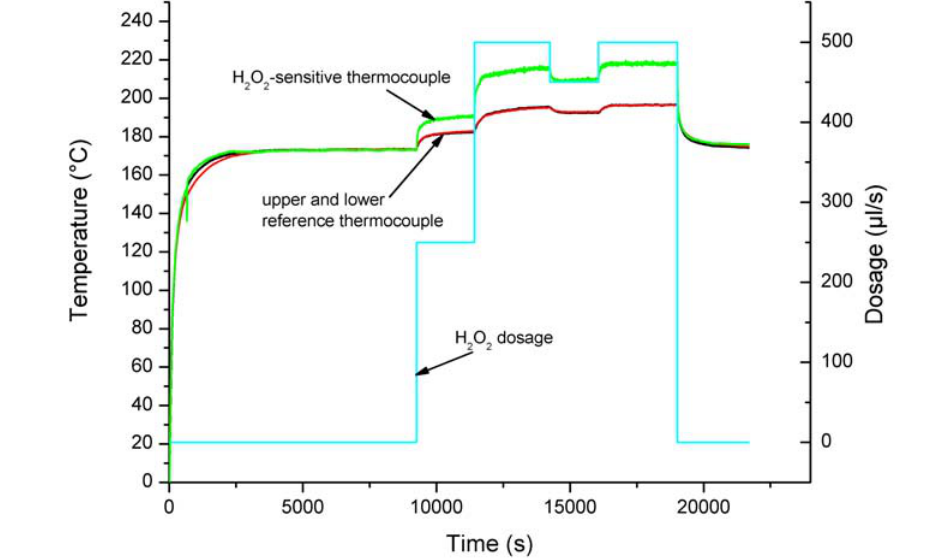
Figure 7. Normalised temperature signal of all